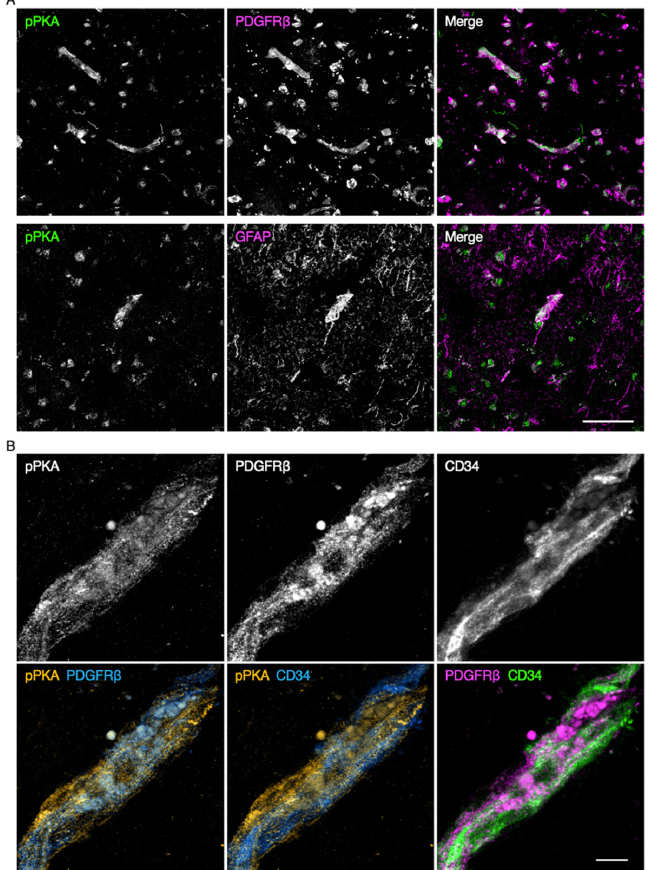
Figure 3. Protein kinase A (PKA) activation in the microvascular endothelial cells and pericytes of the schizophrenic PFC. ( A ) Confocal images of the schizophrenic PFC gray matter stained for phospho-PKA (pPKA) and either PDGFR β or glial fibrillary acidic protein (GFAP). ( B ) Confocal images of the schizophrenic PFC gray matter stained for pPKA, PDGFR β , and CD34. Scale bars, 50 µm (upper); 10 µm (lower).